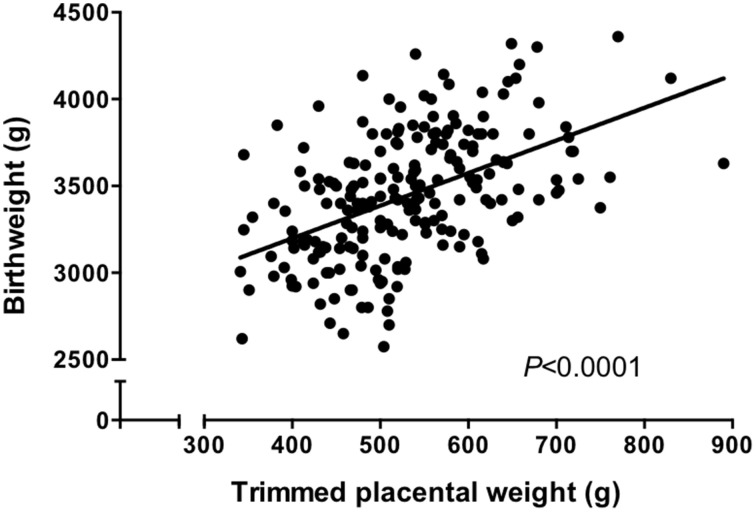
Trimmed placental weight vs. birthweight in an appropriate for gestational age (>10th, < 90th centile of IBCs) population. There was a significant correlation between placental weight and birthweight (P < 0.0001, Spearman correlation). N = 210. Data represents a collation of our previously published data (Ditchfield et al., 2010, 2015; Hayward et al., 2012, 2013; Brereton et al., 2013; Coleman et al., 2013; Lean et al., 2014; Jones et al., 2015; Mills et al., 2015) and represents a well characterized cohort all of whom delivered at St Mary's Hospital, Manchester.